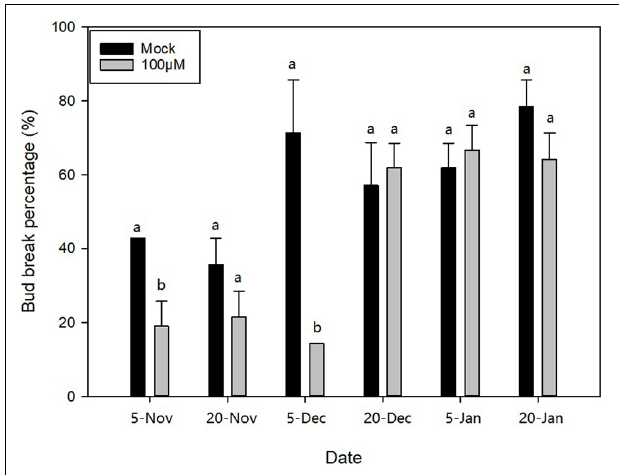
FIGURE 5 | Bud break percentage after abscisic acid (ABA) treatment during endodormancy (ED) to ecodormancy (ECD) during 2020–2021 in Magnolia wufengensis . Each experiment was performed with three biological replicates. Different letters above bars indicate a significant difference among bud break percentage under different concentration of ABA according to ANOVA and LSD test ( p <